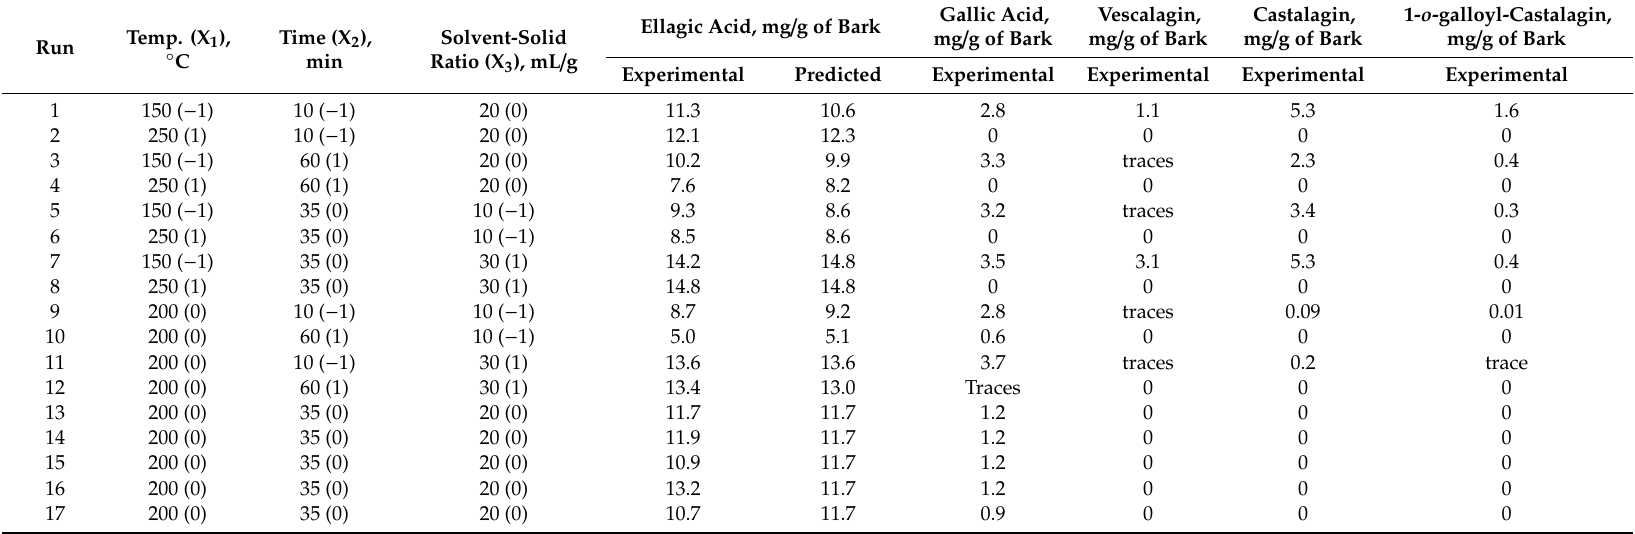
Table 5. Proposed experiments by the Box–Behnken method and the predicted and experimental values of yield of ellagic and gallic acid and ellagitannins obtained by subcritical water extraction of chestnut